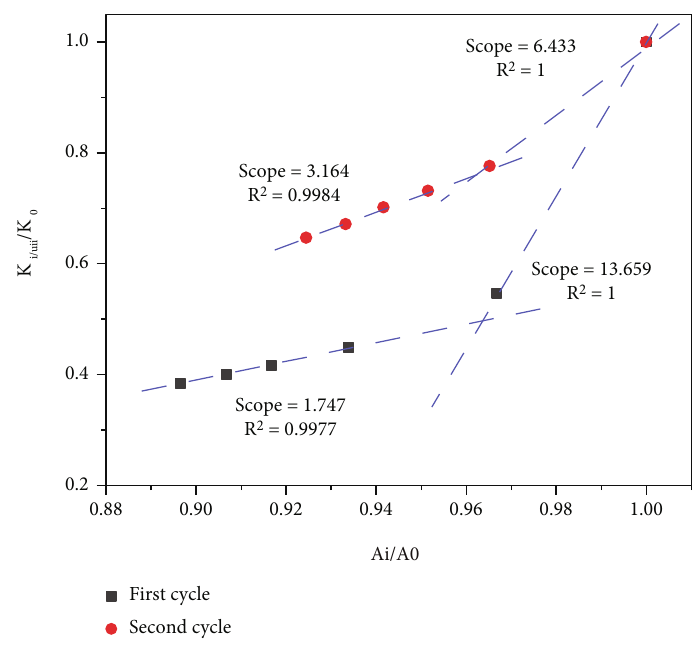
Figure 11: The corresponding between pore volume change and